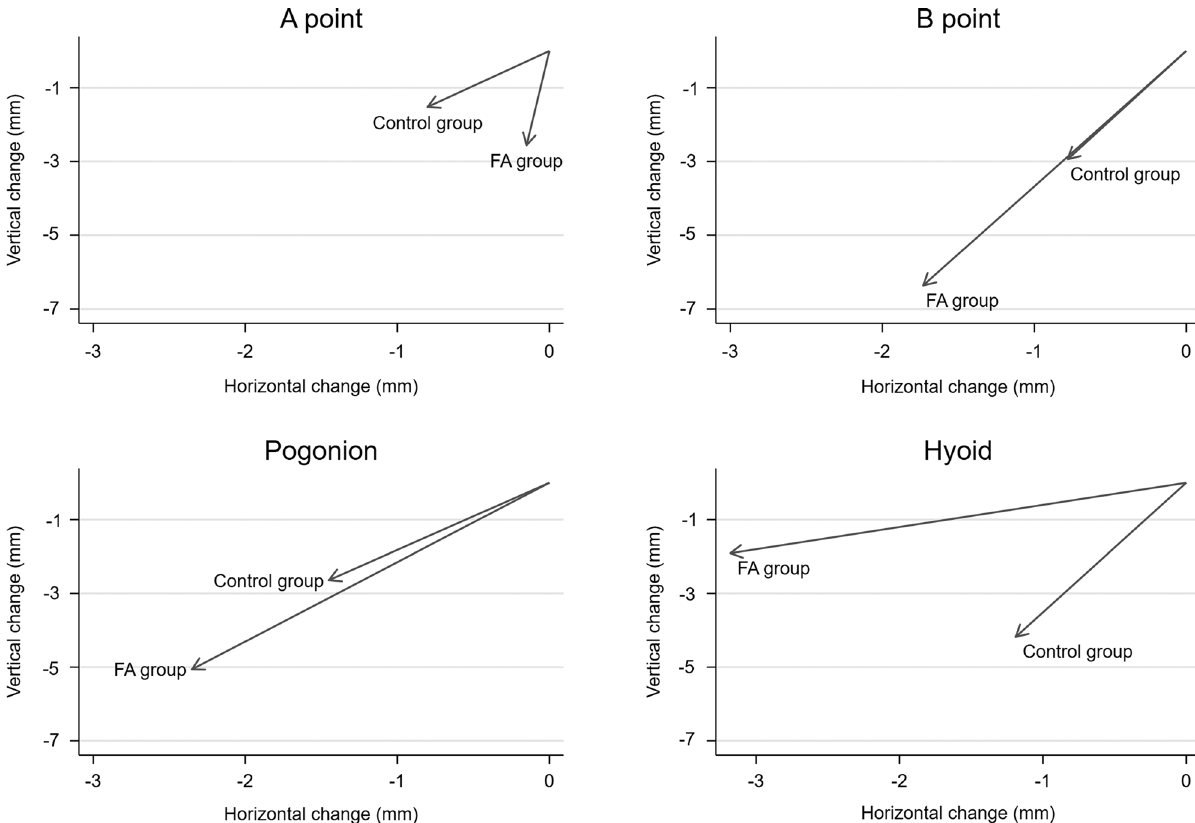
Figure 3. Illustration of the significant skeletal changes (structural method) in the maxilla and mandible of the FA group when compared with the control